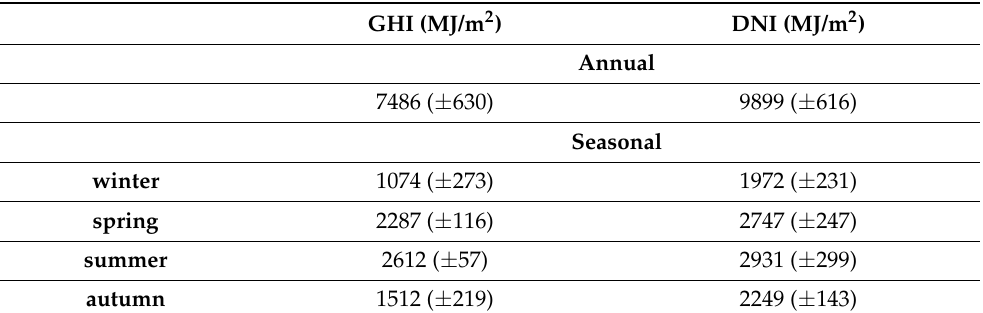
Figure 13. Mean (2003–2017) annual integrals for clear-sky GHI ( a ) and DNI ( b ) using MODIS AOD. Table 7. Regional averages of mean annual and seasonal integrals of clear—sky GHI and DNI using ModIs AOD.